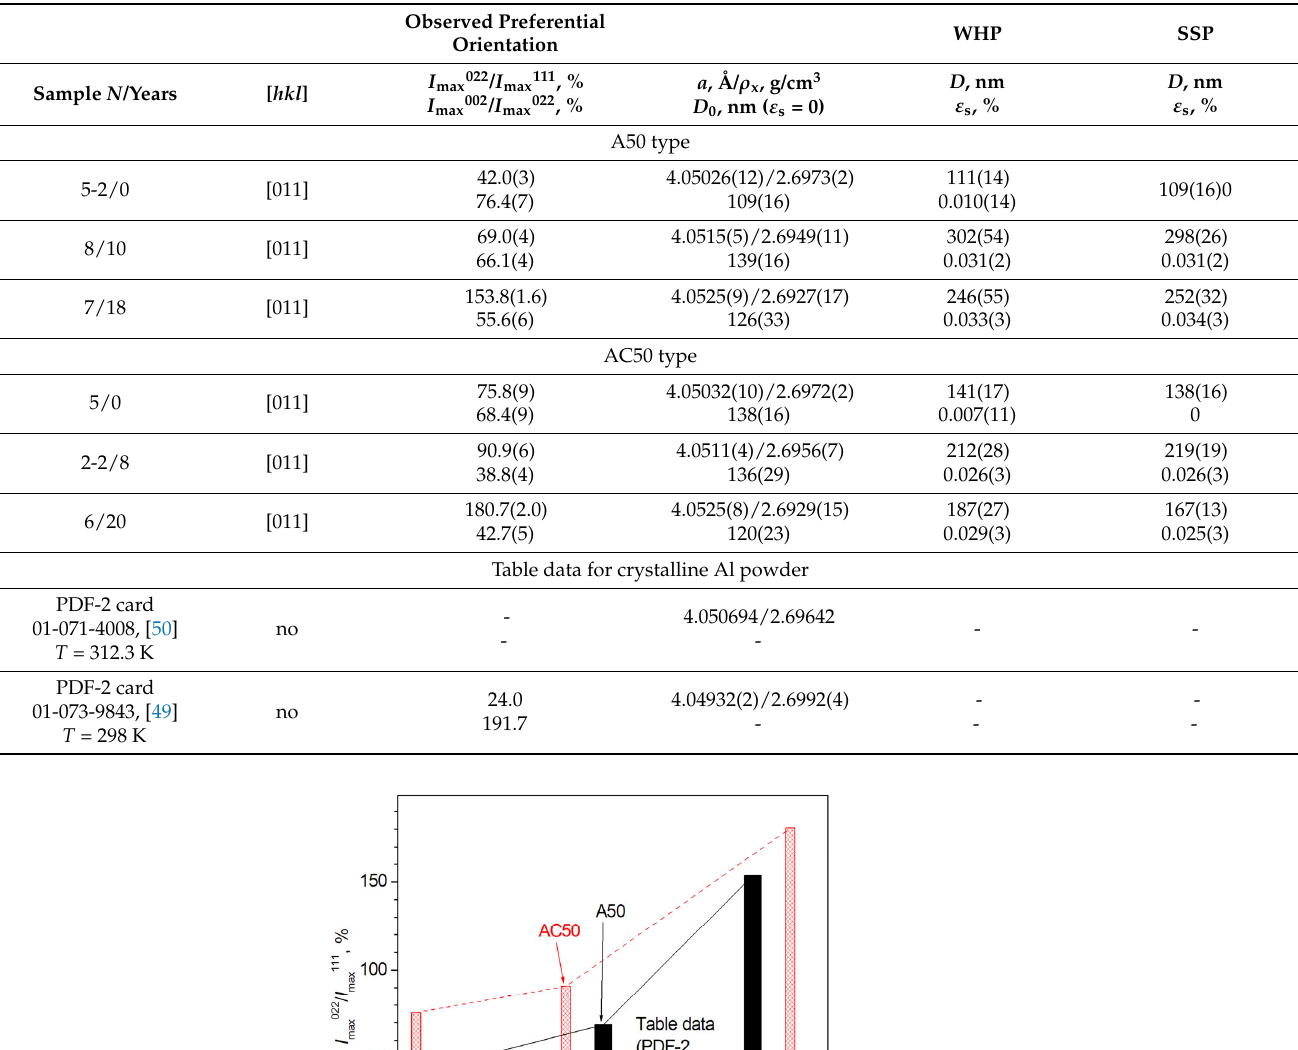
Table 4. XRD analysis results of A50 and AC50 wires (temperature of measurements is T = 314 ± 1 K). Sample numbers and sample service life (years) are given according to Table 2. Table data from PDF ‐ 2 for crystalline Al phase are shown for comparison.